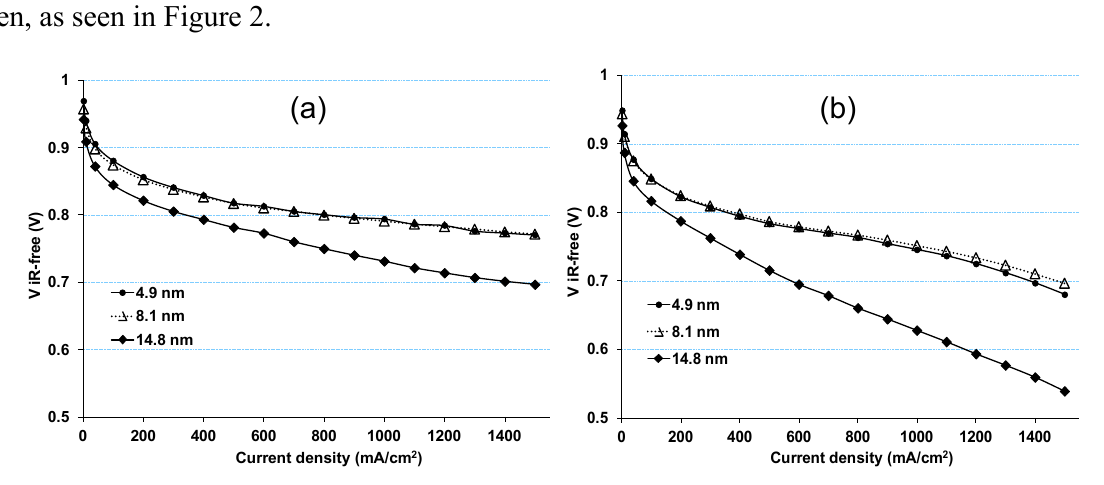
Figure 2. The beginning of life V-I performance of 4.9, 8.1, and 14.8 nm Pt 3 Co catalyst based MEAs, H 2 /O 2 ( a ) and H 2 /Air ( b